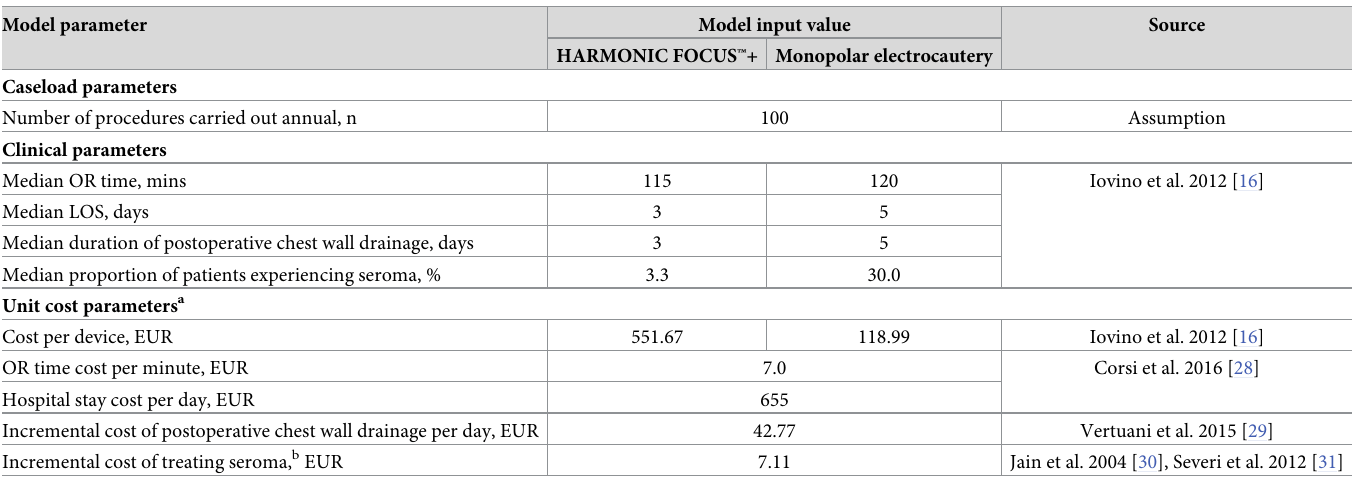
Table 1. Model inputs for the primary